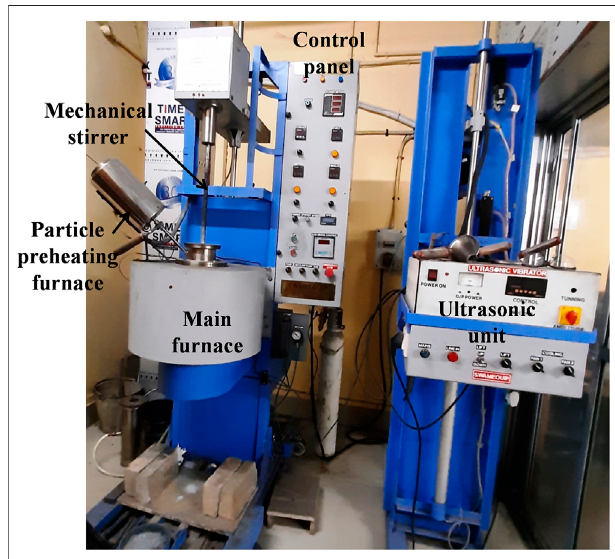
FIGURE 2 | Pictorial view of furnace.